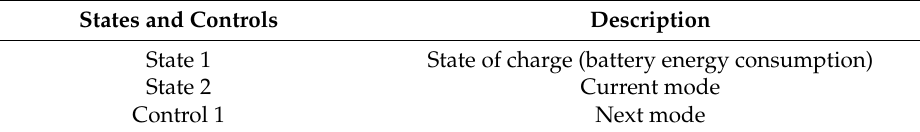
Table 4. The states and controls of the dynamic programming (DP)